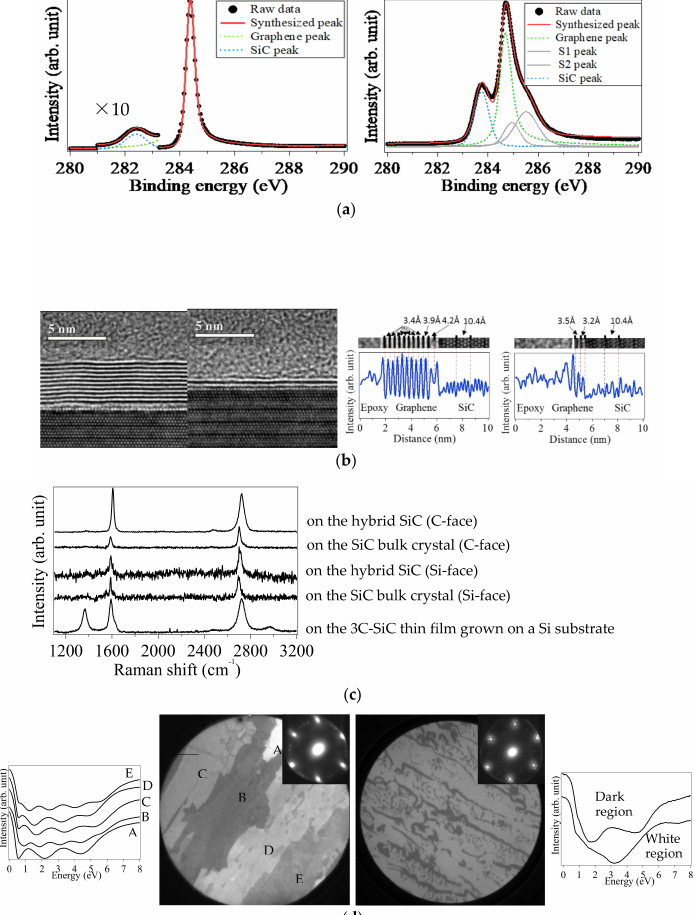
Figure 2. ( a ) C 1s core level spectra of graphene on the C-face (left) and the Si-face (right) hybrid SiC, respectively. ( b ) Transmission electron micrographs and line profiles of the interfaces between the C-face (left) and Si-face (right) hybrid SiC. ( c ) Raman spectra of graphene grown on the C-face of hybrid SiC and of the SiC bulk crystal, Si-face of hybrid SiC and the SiC bulk crystal, and the 3C-SiC thin film grown on the Si substrate from the top to the bottom, respectively. ( d ) LEEM images and electron spectra of graphene on the C-face (left) and Si-face (right) hybrid SiC, respectively. The field of view is 30 µ m, and the energy of the incident electron for the LEEM imaging is 2 eV. The insets are µ -LEED taken from the observed